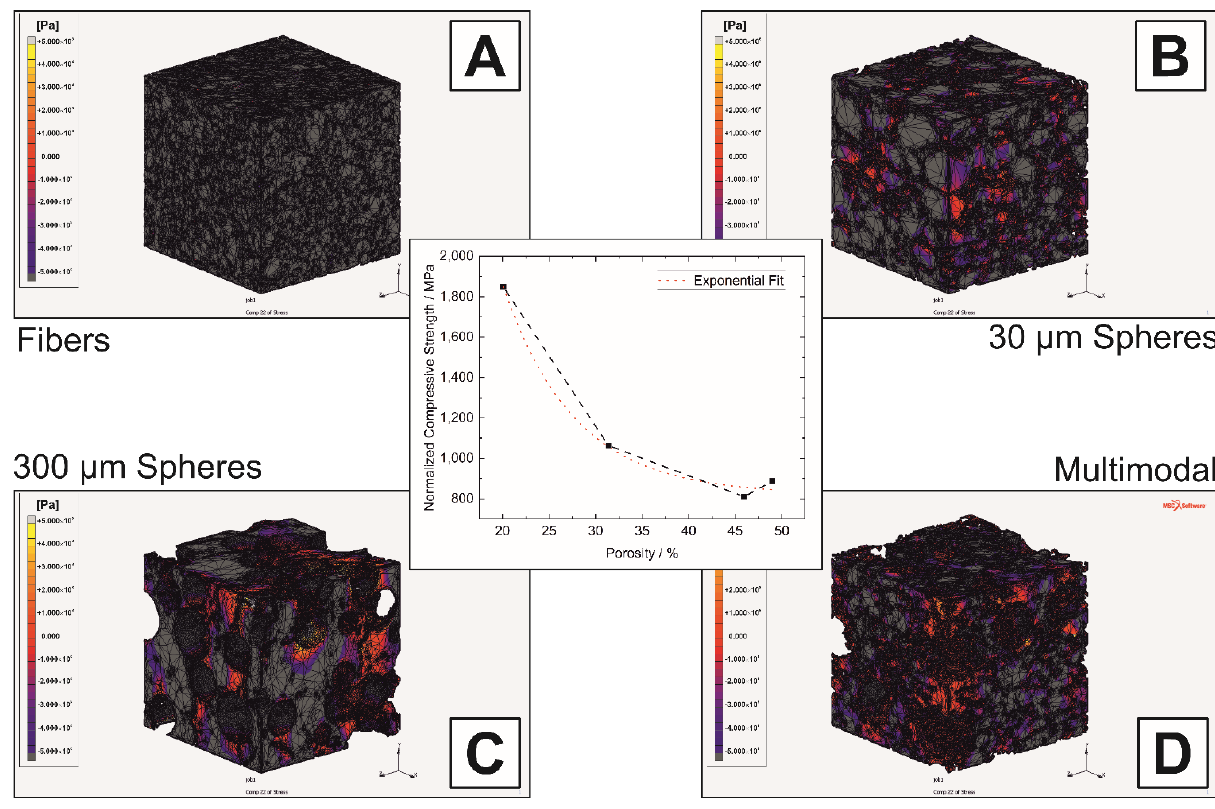
Figure 10. Stress distribution in σ yy of the monomodal samples with fibrous ( A ), 30 µm ( B ) and 300 µm spherical pores ( C ) and the multimodal sample ( D ) with assigned displacement of 0.1% on top face; the corresponding compressive stress is shown in the middle. The legend shows the range from +500 MPa to − 500 MPa.